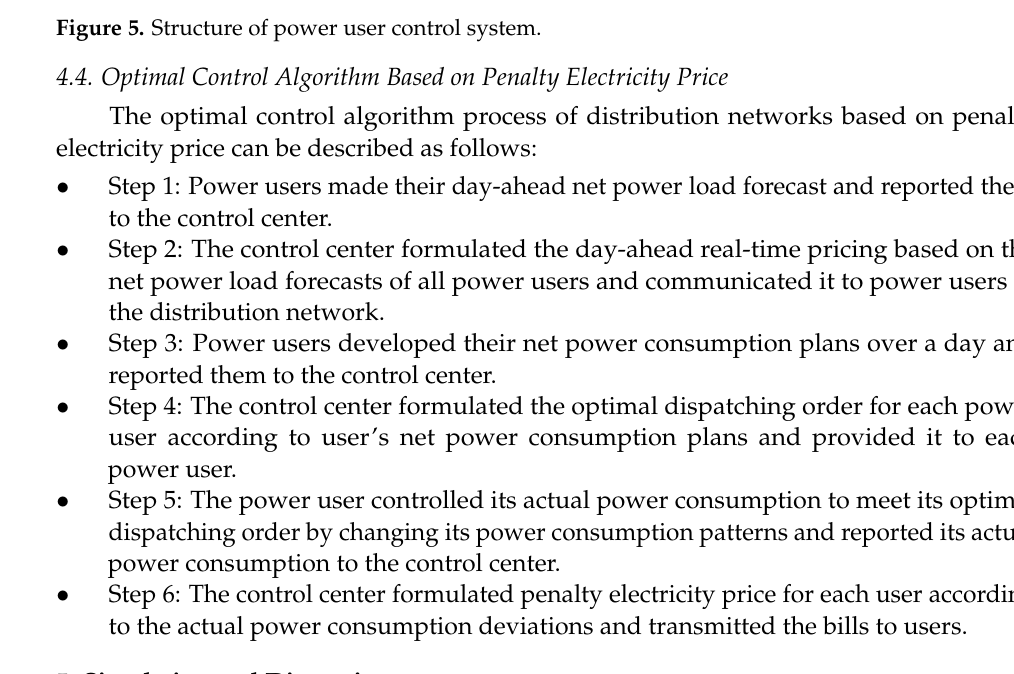
Figure 7. Day-ahead real-time pricing.